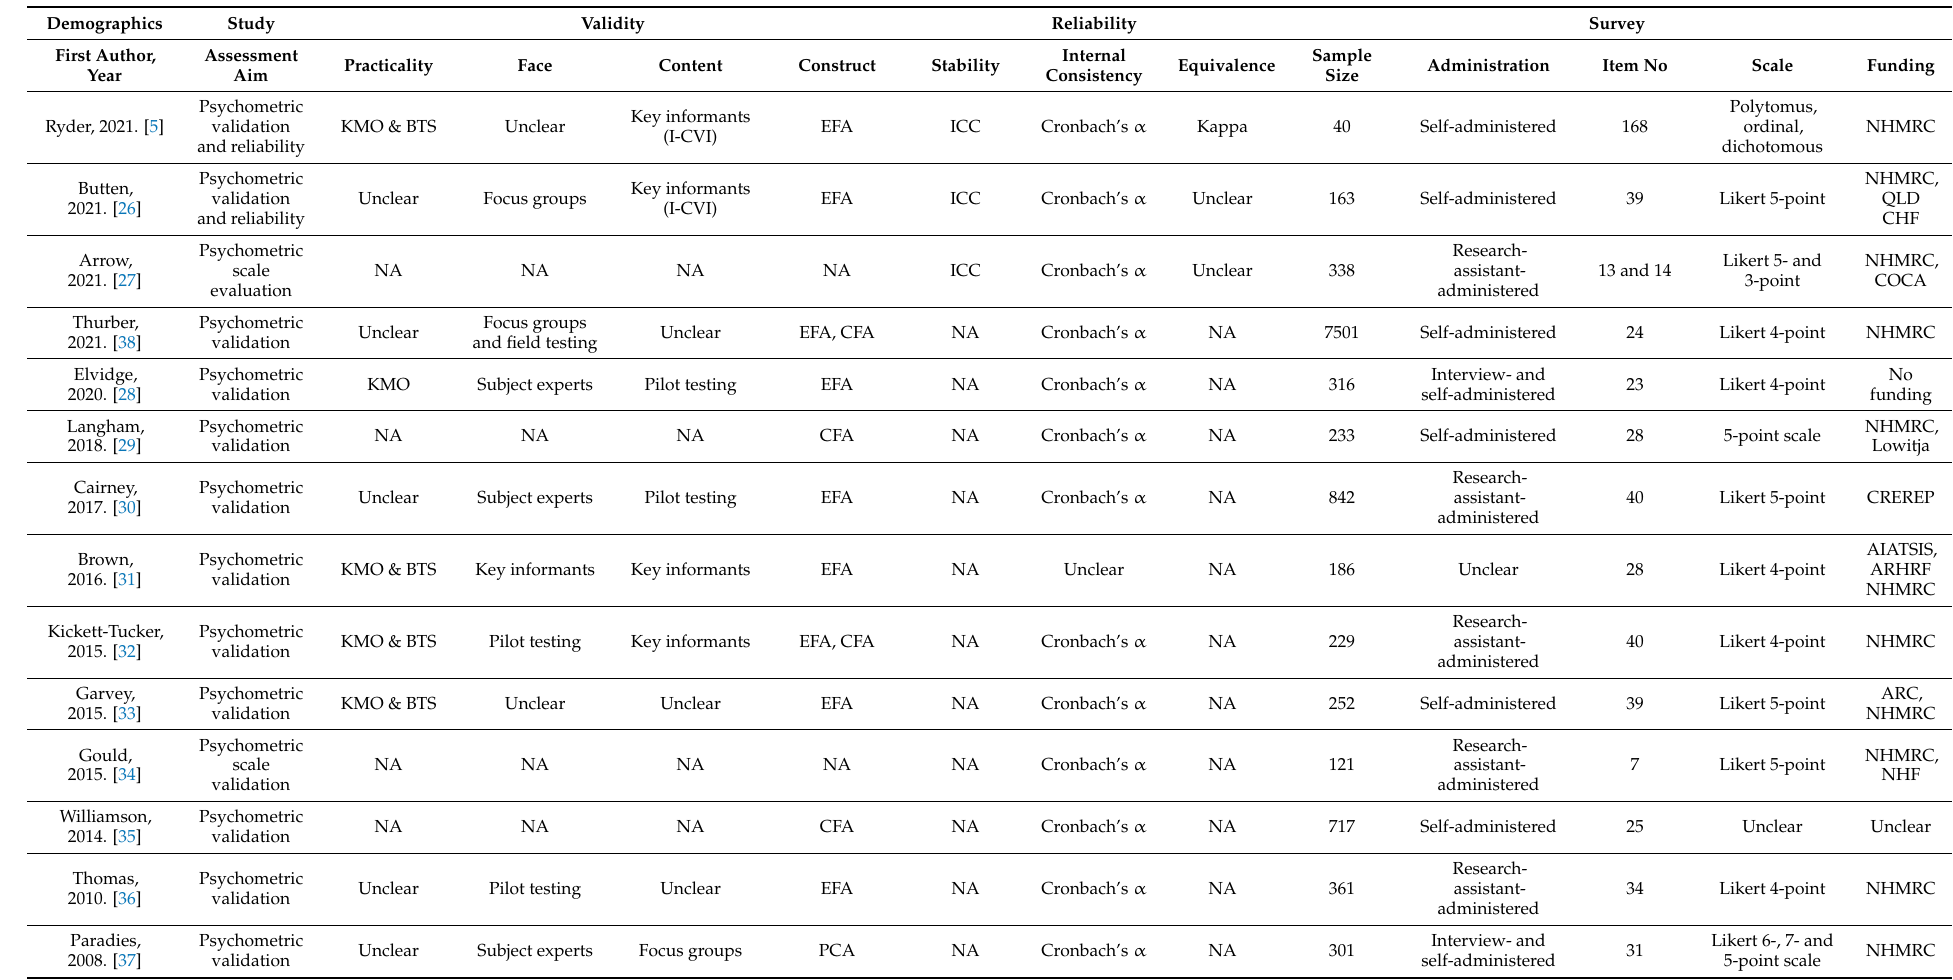
Table 4. Survey design. Note: data sorted according to publication